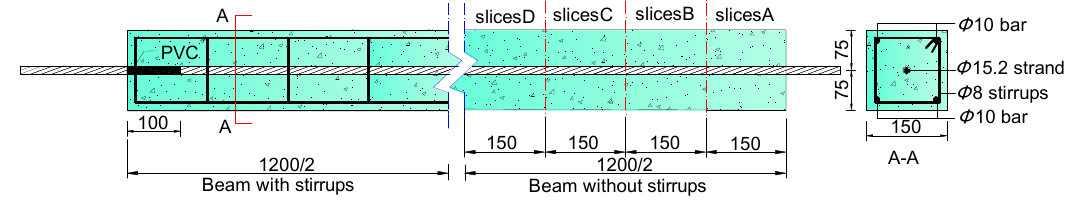
Figure 1. Details of the beam (unit: mm).